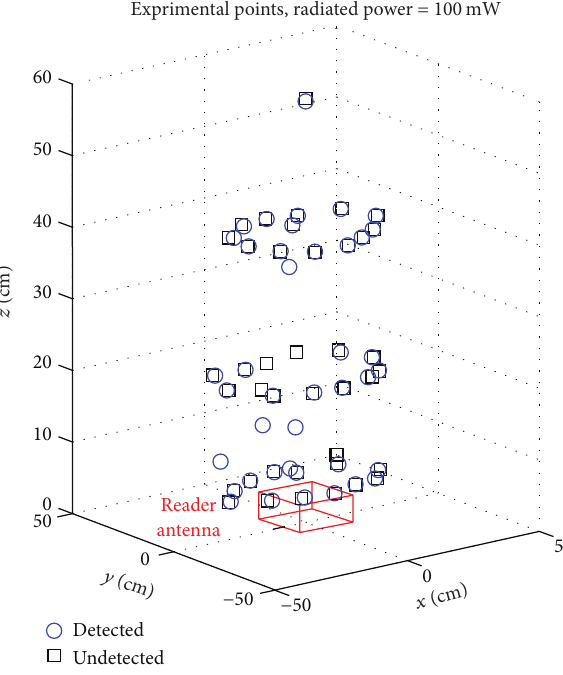
F 11: Experimental points of detection, UHF RFID system, for a radiated power of 100mW.